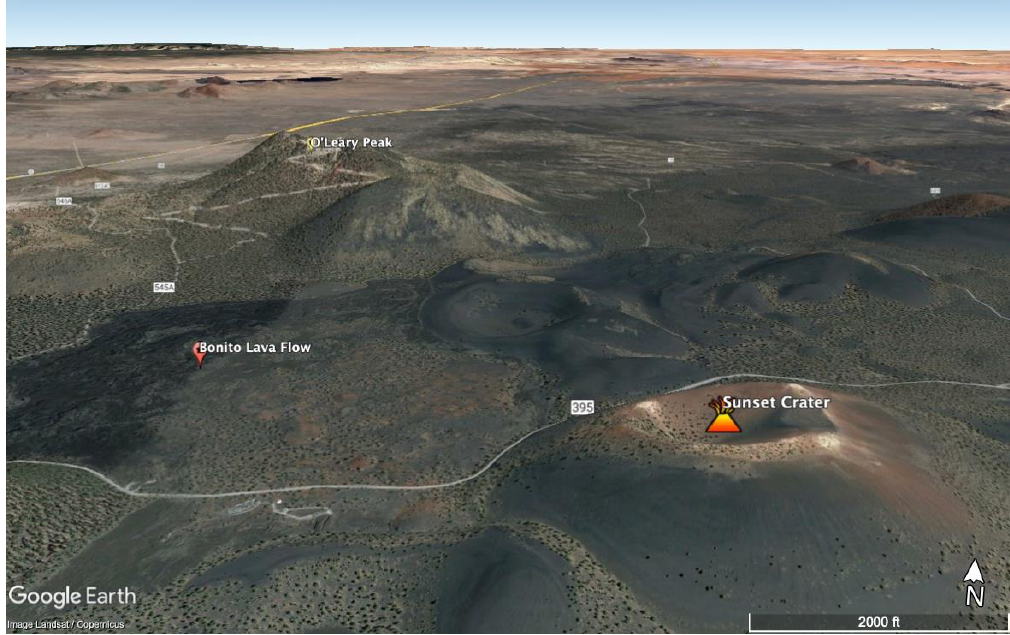
Figure 5. Sunset Crater and the San Francisco Volcanic Field.